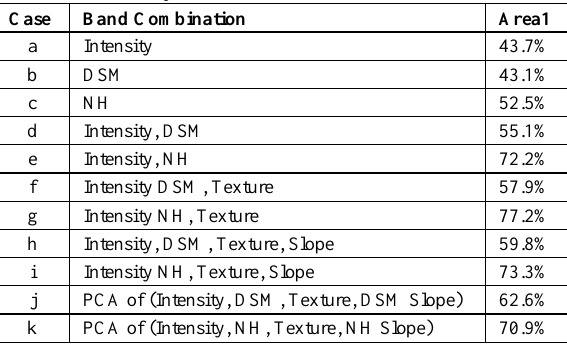
Table 1: Accuracy assessments of the land cover classification